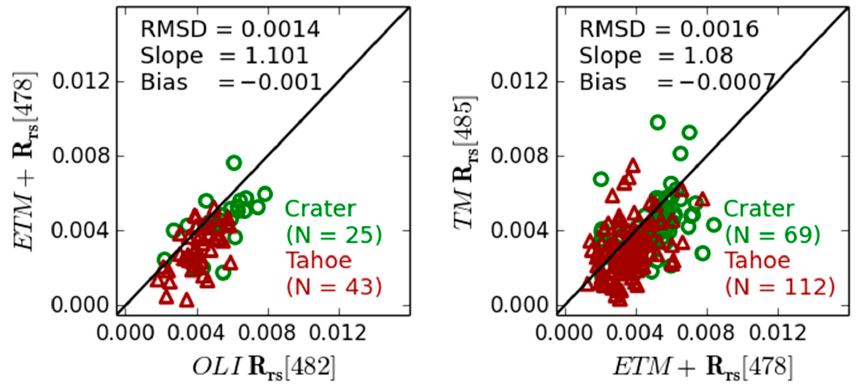
Figure 5. The scatterplots obtained from intercomparisons of OLI-ETM+ and TM-ETM+ R rs products over optically stable waters of Crater and Tahoe lakes. The gains tabulated in Table 2 were supplied to SeaDAS to generate these products. Final gains are tabulated in Table 3. Note that the image pairs were acquired 8 days apart. Table 3. The final vicarious gains for after slight adjustments made to gains enlisted in Table 2. The adjustments were minimal for the green bands. Note that no change was made to the SWIR-II channels.